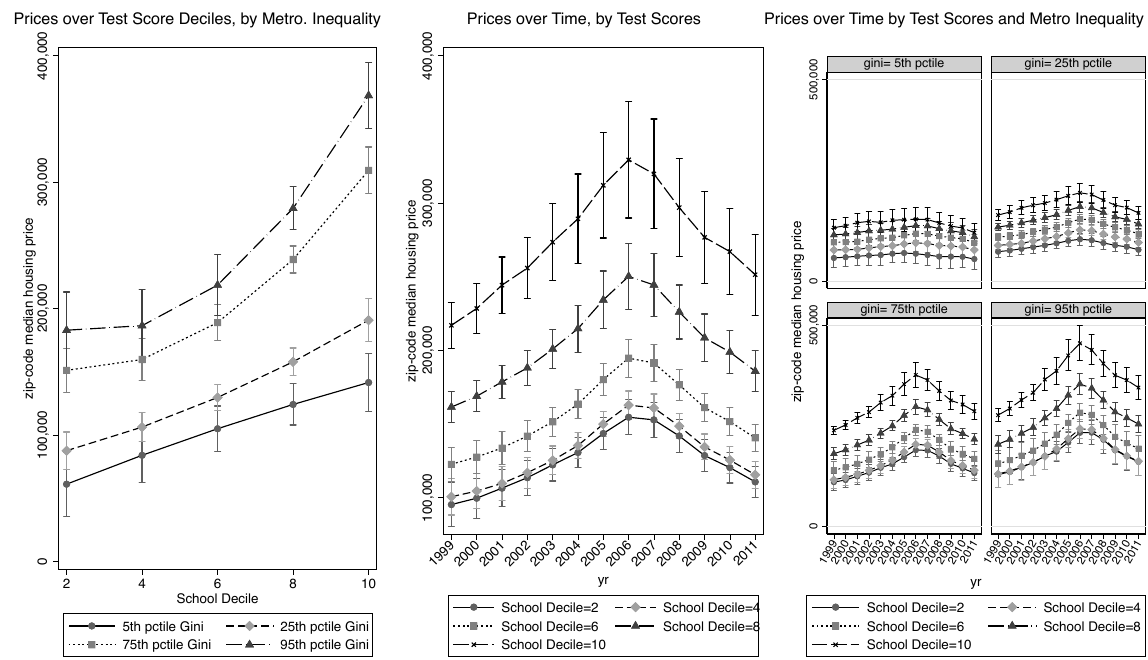
Figure 1: Housing prices by level of test-score decile, income inequality, and year. model includes a quadratic term for school decile, and the effects of inequality are allowed to vary across time- and school-decile levels. Predicted prices are then calculated from the estimates and presented in Figure